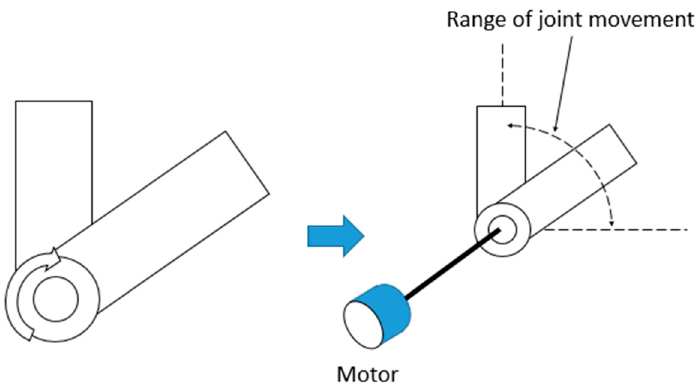
Figure 2 . Block diagram of revolute joint of the prototype and its movement range. Figure 2. Block diagram of revolute joint of the prototype and its movement